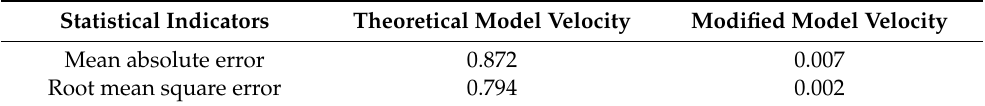
Table 3. Comparison of model